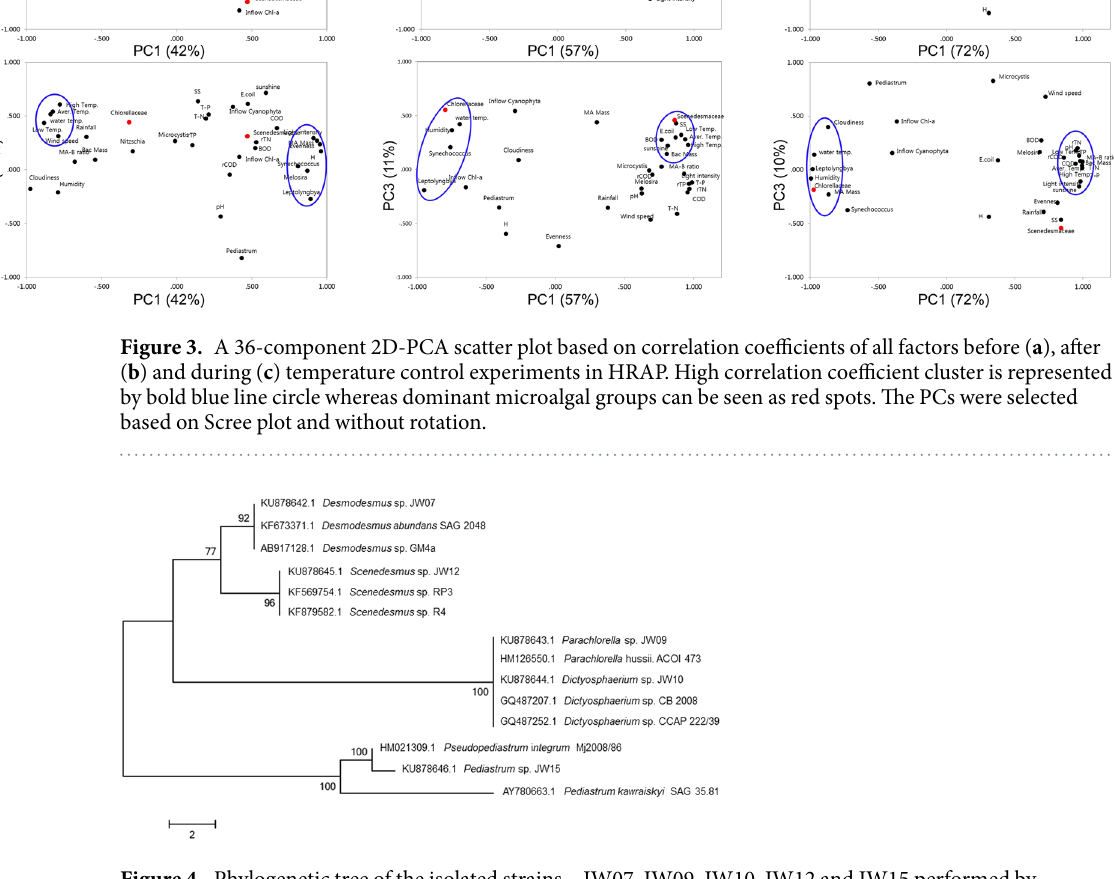
Figure 4. Phylogenetic tree of the isolated strains – JW07, JW09, JW10, JW12 and JW15 performed by neighbour-joining algorithm in the MEGA 5 software with bootstrap values based on 1000